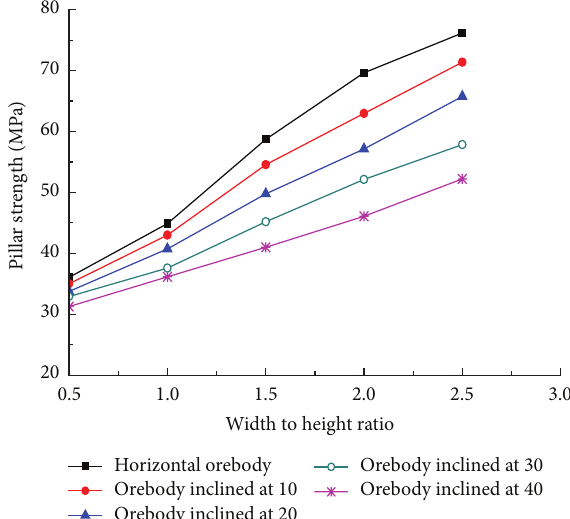
Figure 20: Pillar strength at various inclinations for various width- to-height ratios for 𝑘 𝑜 of 1.5.